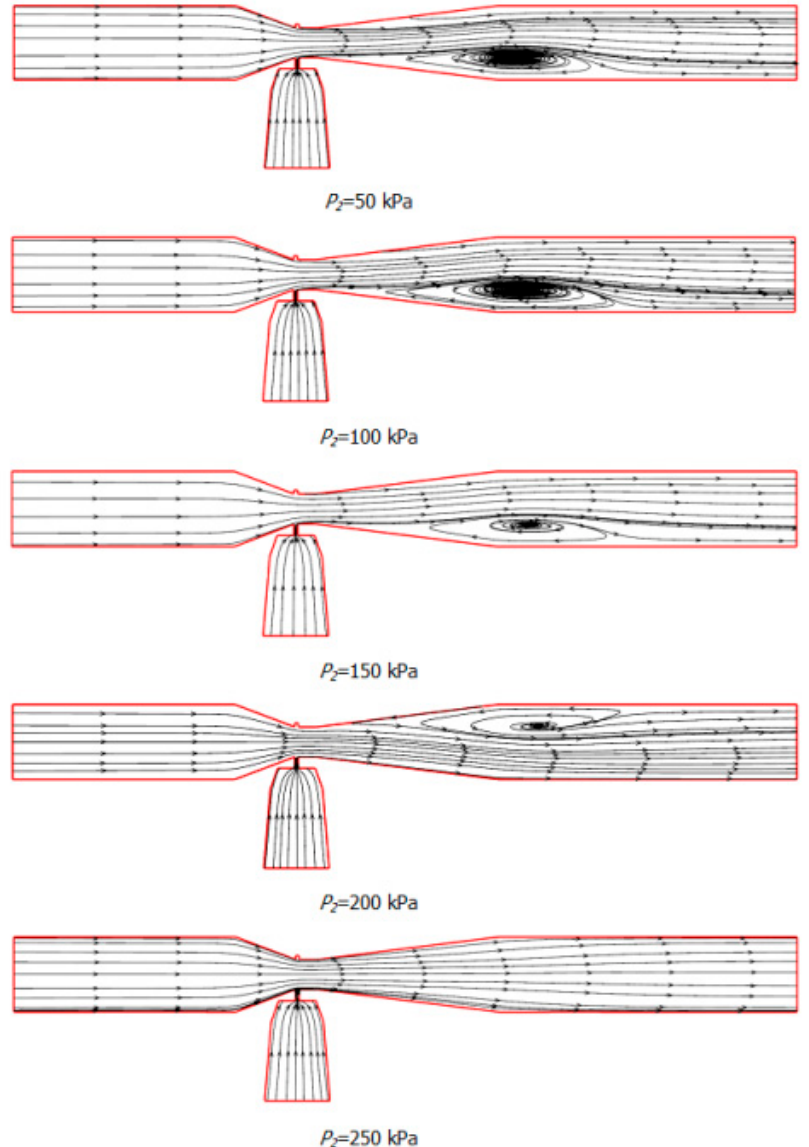
Figure 8. Streamlines in the z = 0 section.